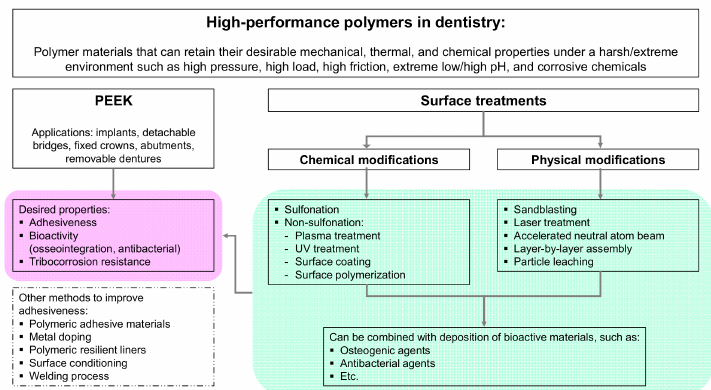
Figure 1. Discussion scope of this review